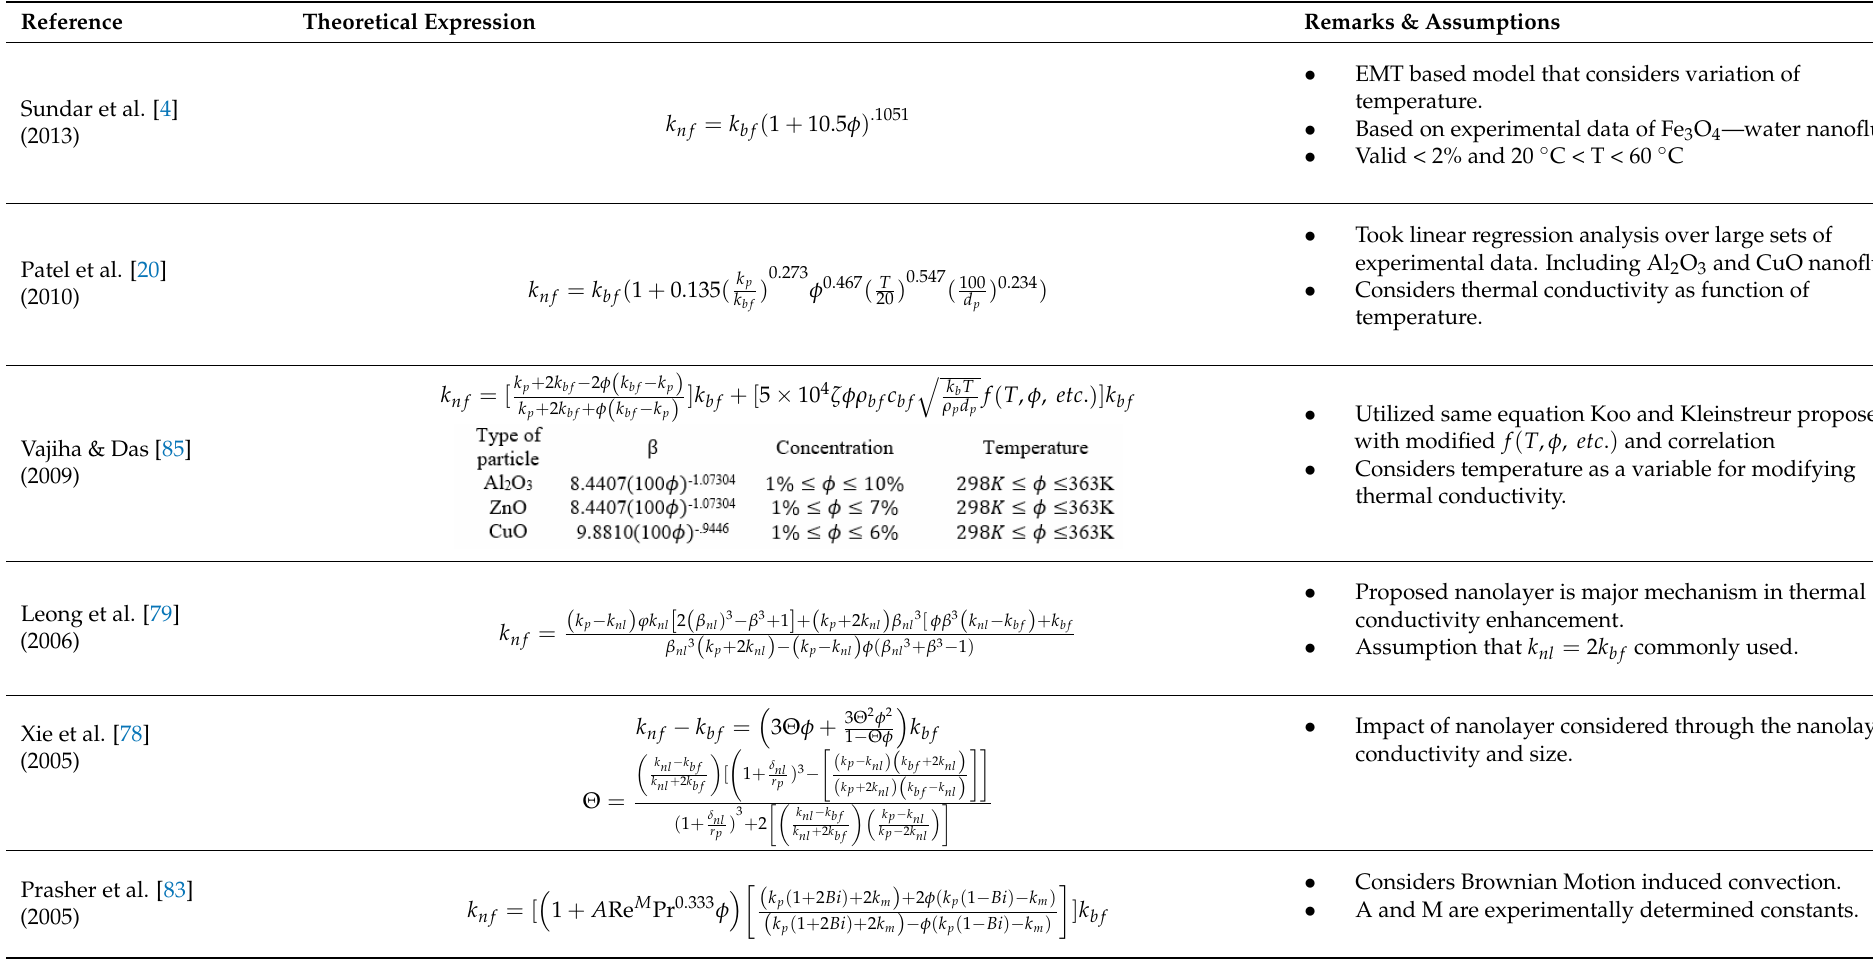
Table A2. Summary of existing theoretical modeling